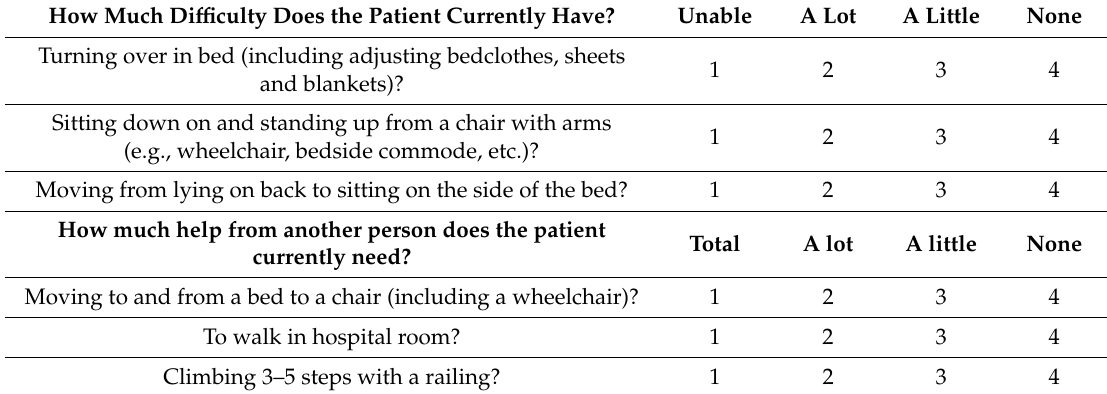
Table 1. Boston University AM-PAC “6-clicks” Basic Mobility Inpatient Short